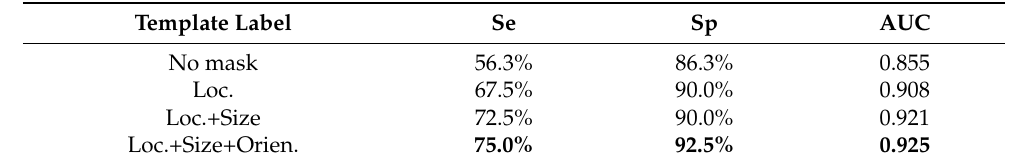
Table 3. Comparison on set of characteristics utilized for creating Mask Label; position, diameter, orientation , posterior eco pattern . Metrics ranked with 1st place are in bold.